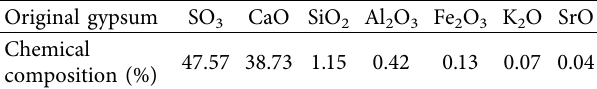
Table 1: Chemical composition analysis of original gypsum.